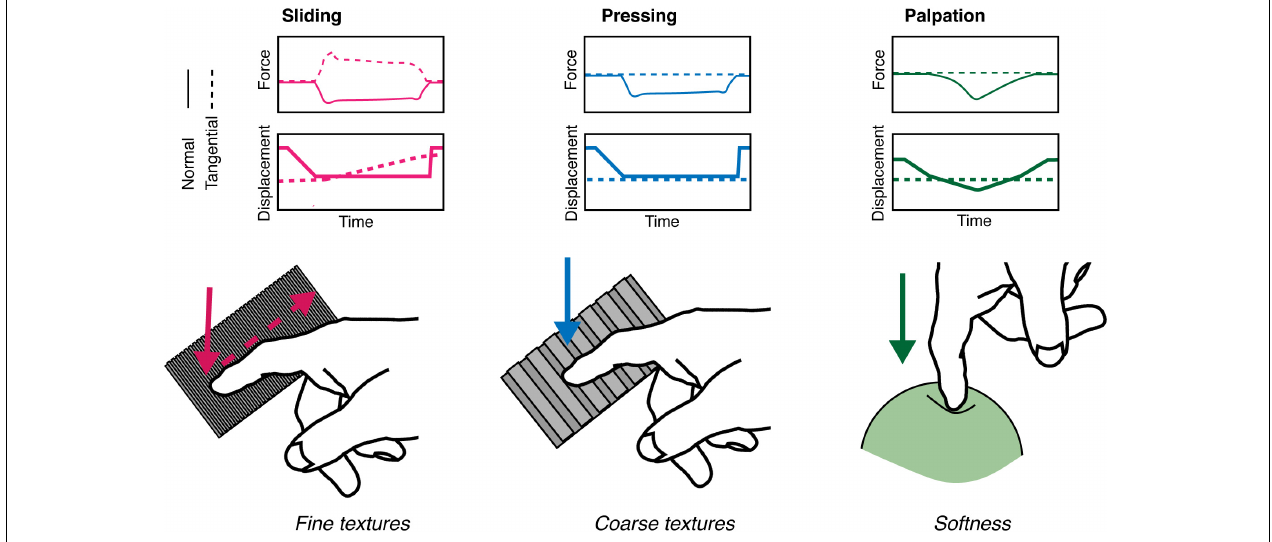
FIGURE 1 | Schematic view of exploratory movements. Surface texture (e.g., periodicity of a spatial grating, or roughness of sandpaper) may be felt by static pressing or sliding contact of the index finger with the normal and tangential force components as shown. Sliding is critical in discriminating very fine texture as it generate skin vibrations which reflect the sensed